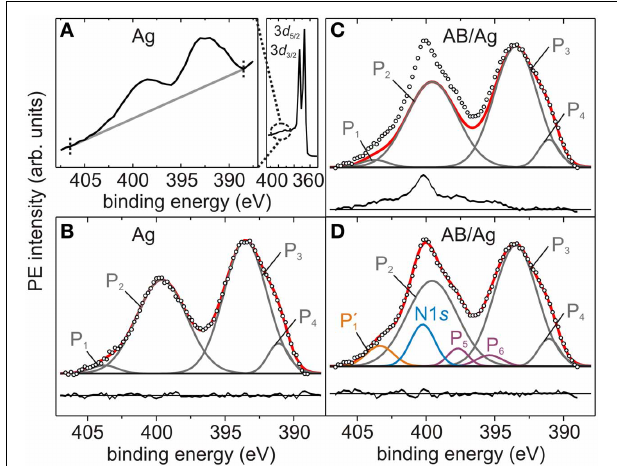
FIGURE 2 | Photoelectron spectra of Ag3 d -plasmons and N1 s core level. (A) Sum of 14 survey-PE spectra (solid black curve) of Ag3 d 5 / 2 , Ag3 d 3 / 2 (right) and Ag3 d -plasmons (enlargement in left panel), measured at h ν = 2617 eV on the bare Ag(111) crystal. The two dotted black lines define the binding energy region in which the linear background (gray line) is determined and XSW-PE spectra are fitted. (B) Sum of 93 Ag3 d -plasmons XSW-PE spectra acquired in three NIXSW data sets of the bare Ag(111) crystal. (C,D) Sum of 93 N1 s + Ag3 d -plasmons XSW-PE spectra acquired in three NIXSW data sets of AB/Ag(111). (B–D) Empty black circles: summed PE intensity. Gray curves: P 1 , P 2 , P 3 , P 4 components. Blue curve: N1 s peak. Orange curve: P (cid:3) 1 component. Purple curves: P 5 , P 6 components. Black straight line: linear background. Black curves: residuals (summed PE intensity - sum of fitting components) plotted below each PE